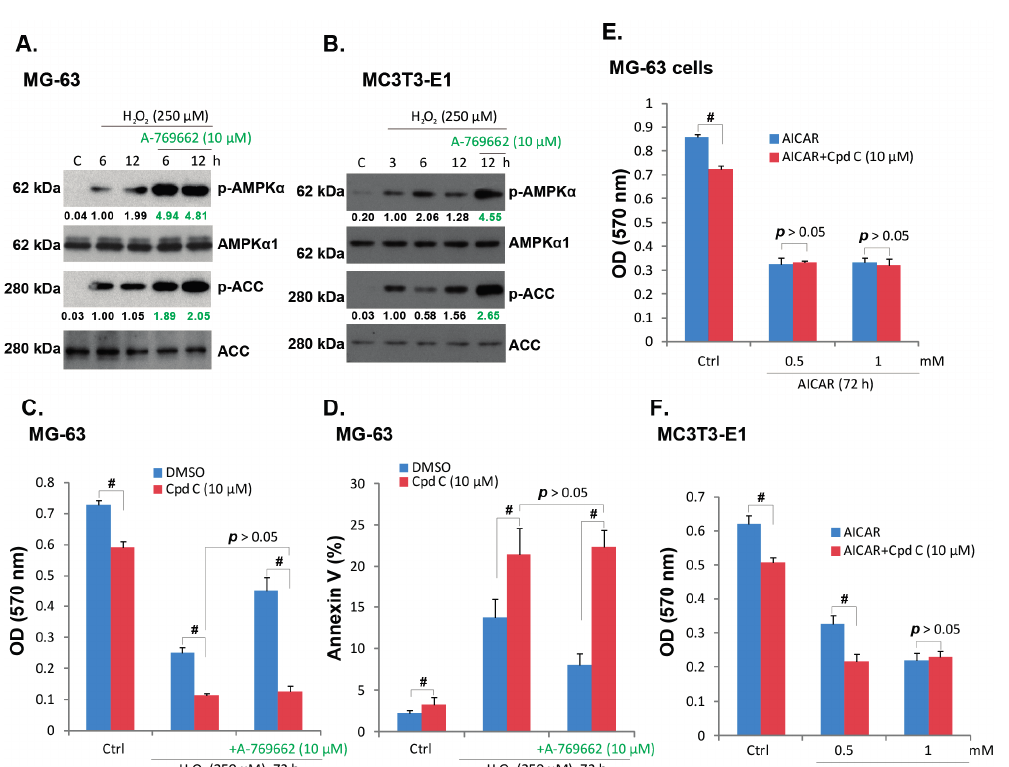
Figure 3. A-769662-induced pro-survival effect against H O requires AMP-activated 2 2 protein kinase (AMPK) activation. MG-63 and MC3T3-E1 cells were pre-treated with A-769662 (10 μ M) for 1 h, followed by hydrogen peroxide (H O , 250 μ M) stimulation, 2 2 cells were further cultured for indicated time points, and western blots were performed to test phospho(p)- and total (t)-AMPK α , p- and t- ACC ( A ) and ( B ); MG-63 and MC3T3-E1 cells were pre-treated with AMPK inhibitor compound C (Cpd C, 10 μ M) for 2 h, followed by hydrogen peroxide (H O , 250 μ M) or H O + A-769662 (10 μ M) stimulation, cells were 2 2 2 2 further cultured, cell viability ( C ) and Annexin V percentage ( D ) were tested as described; MG-63 and MC3T3-E1 cells were pre-treated with compound C (Cpd C, 10 μ M) for 2 h, followed by AICAR (0.5 and 1 mM) stimulation, cells were further cultured for 72 h when cell viability was examined ( E ) and ( F ). # p < 0.05.